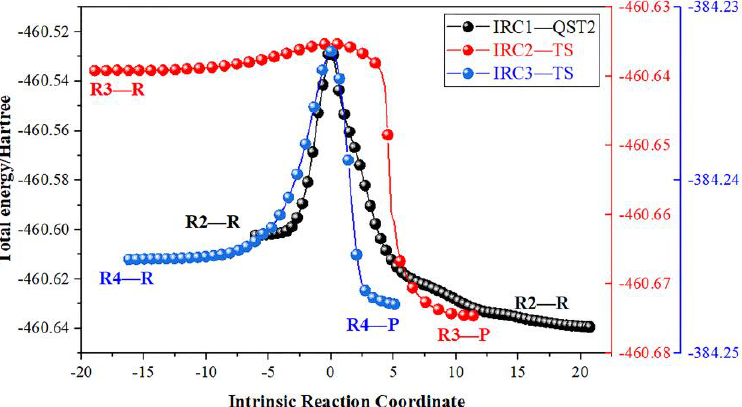
Figure 10. IRC curves. Table 4. Thermodynamic parameters.